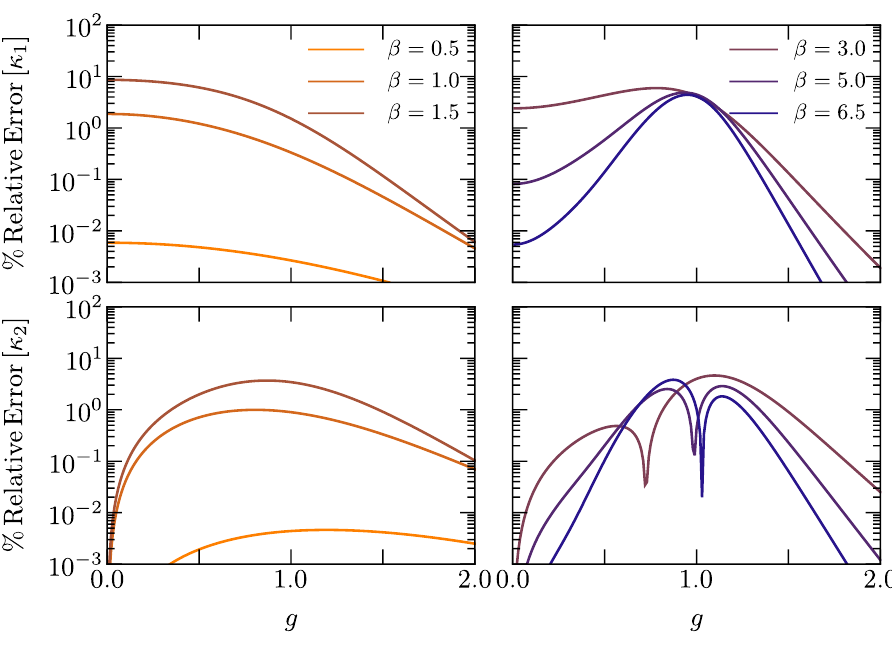
Figure 10: Relative error for the first two cumulants of the magnetization distri- bution as a function of magnetic field g . Using the full characteristic function in Eq. (101) and the corresponding PPA Eq. (105), the relative error is evaluated as a function of the magnetic field for a system size L = 12 and different temperatures.